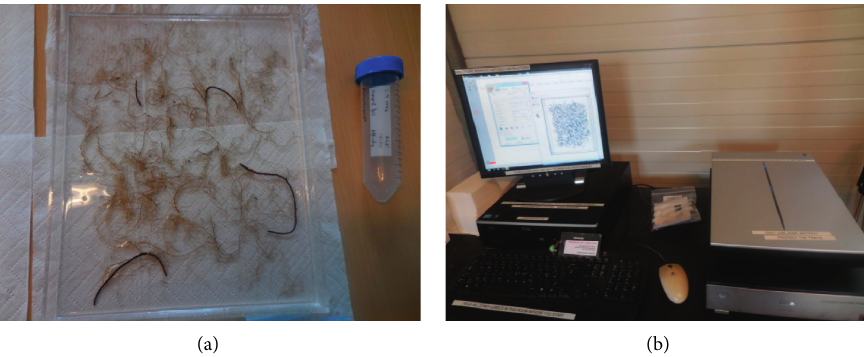
Figure 3: Root sample is placed in the root tray (a), for RLD determination using an EPSON ® scanner and Winrhizo ® software (b).